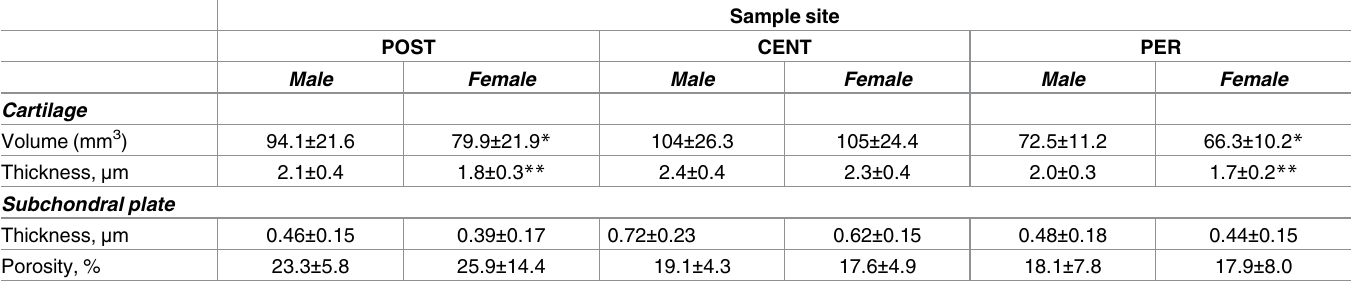
Table 2. Micro-CT results for cartilage and subchondral plate (SCP) at the three sample sites by